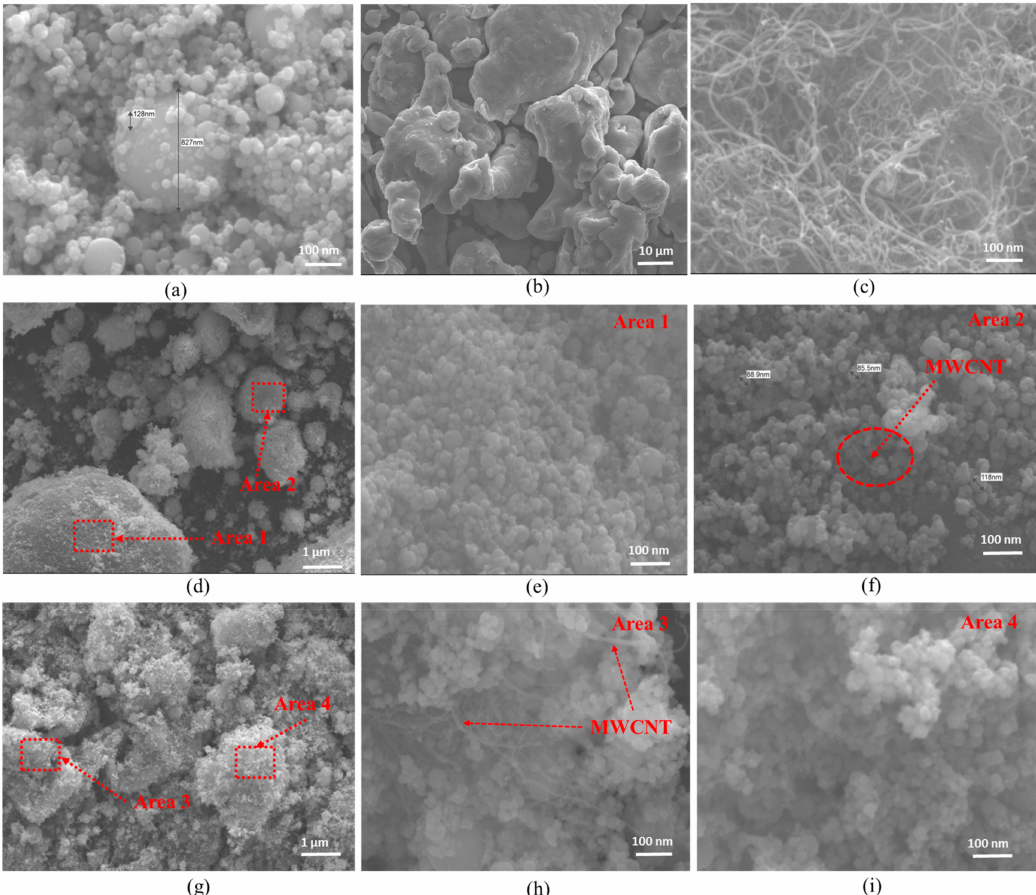
Figure 1. SEM images of powders: ( a ) As-received Fe nanopowders; ( b ) As-received Al powders; ( c ) As-received MWCNT; ( d ) Ball-milled (38Fe-60Al-2MWCNT) powders; ( e ) and ( f ) Higher Magnification of Selected Areas (1&2) in the images ( d ); ( g ) Ball-milled (65Fe-33Al-2MWCNT) powders; ( h ) and ( i ) Higher Magnification of Selected Areas (3&4) in the images ( g